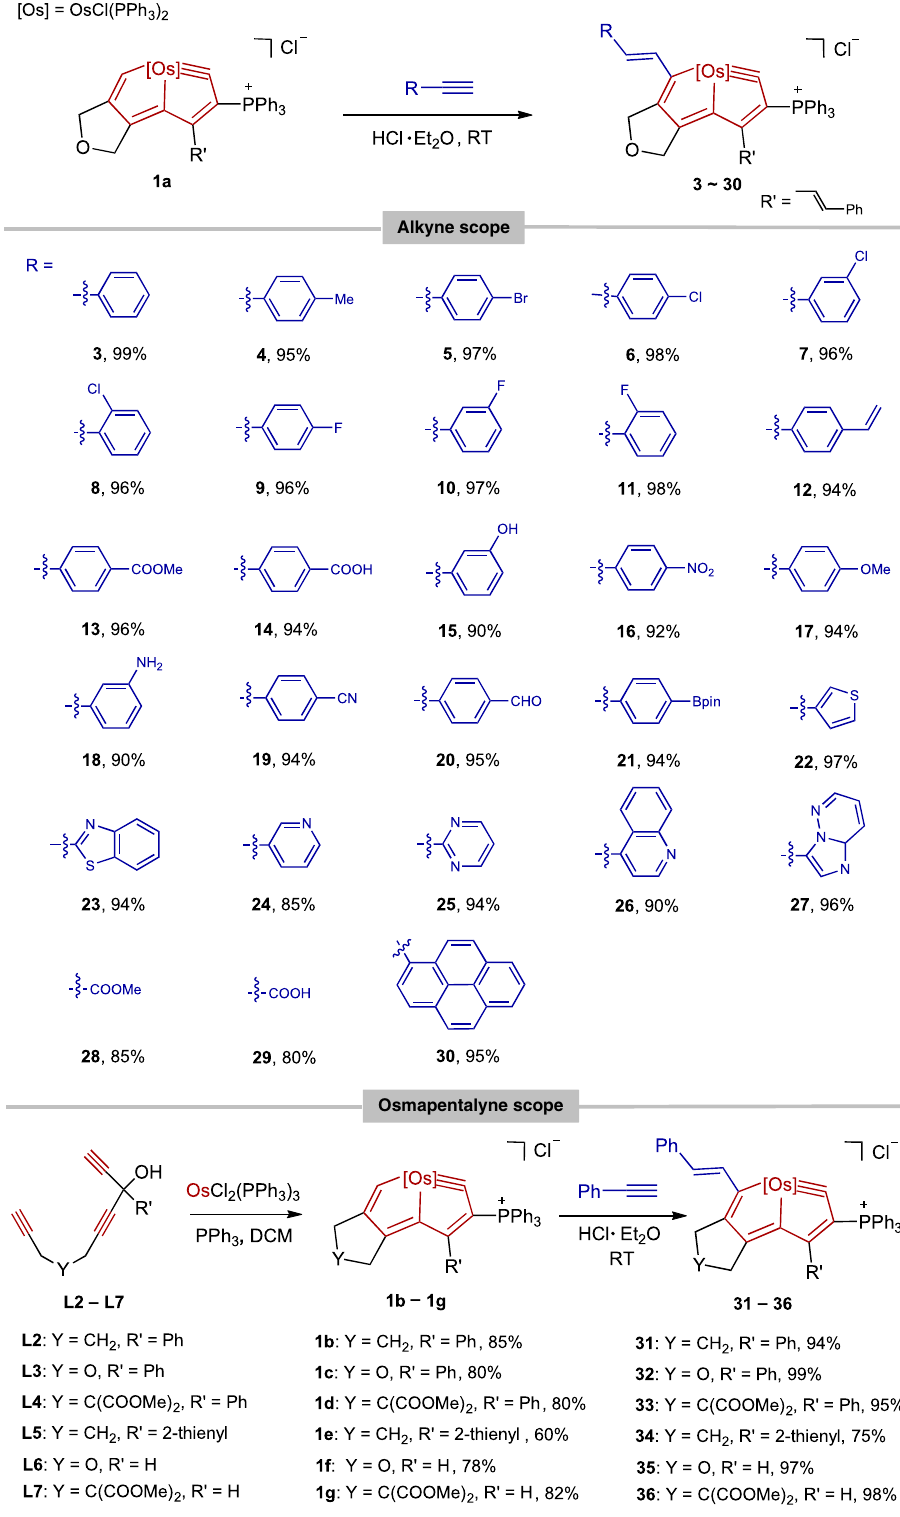
Fig. 4 Substrate scope. The substrate scope of the alkynes and